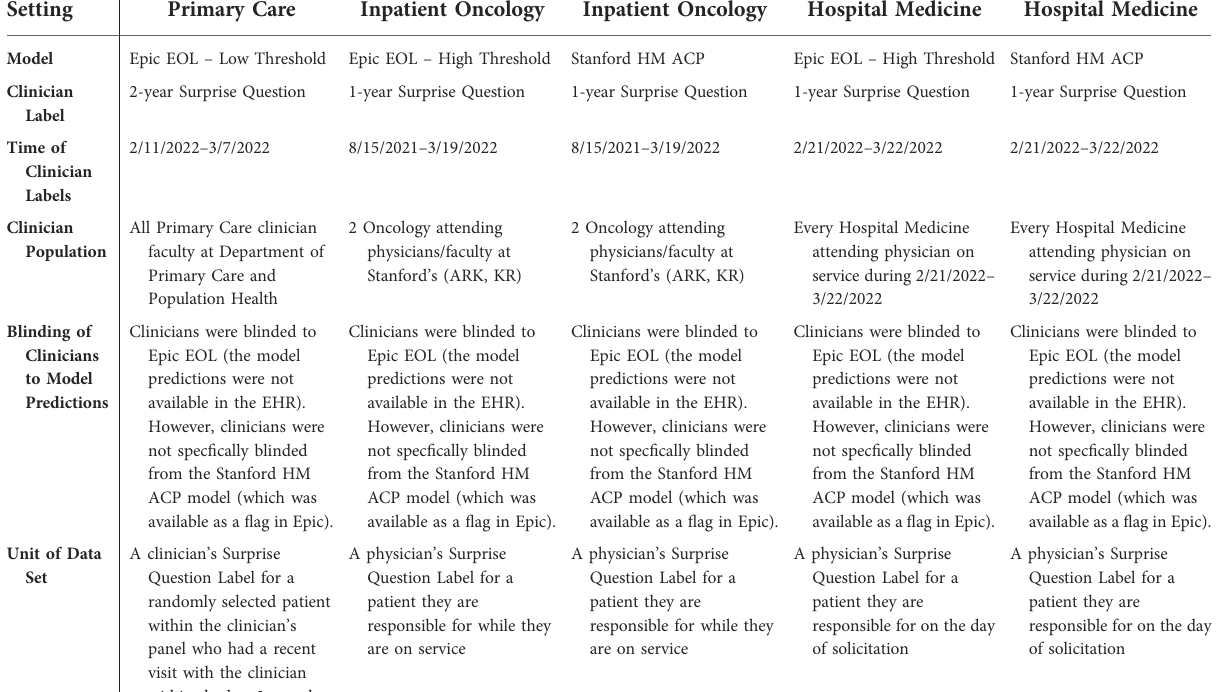
TABLE 2 Clinician label